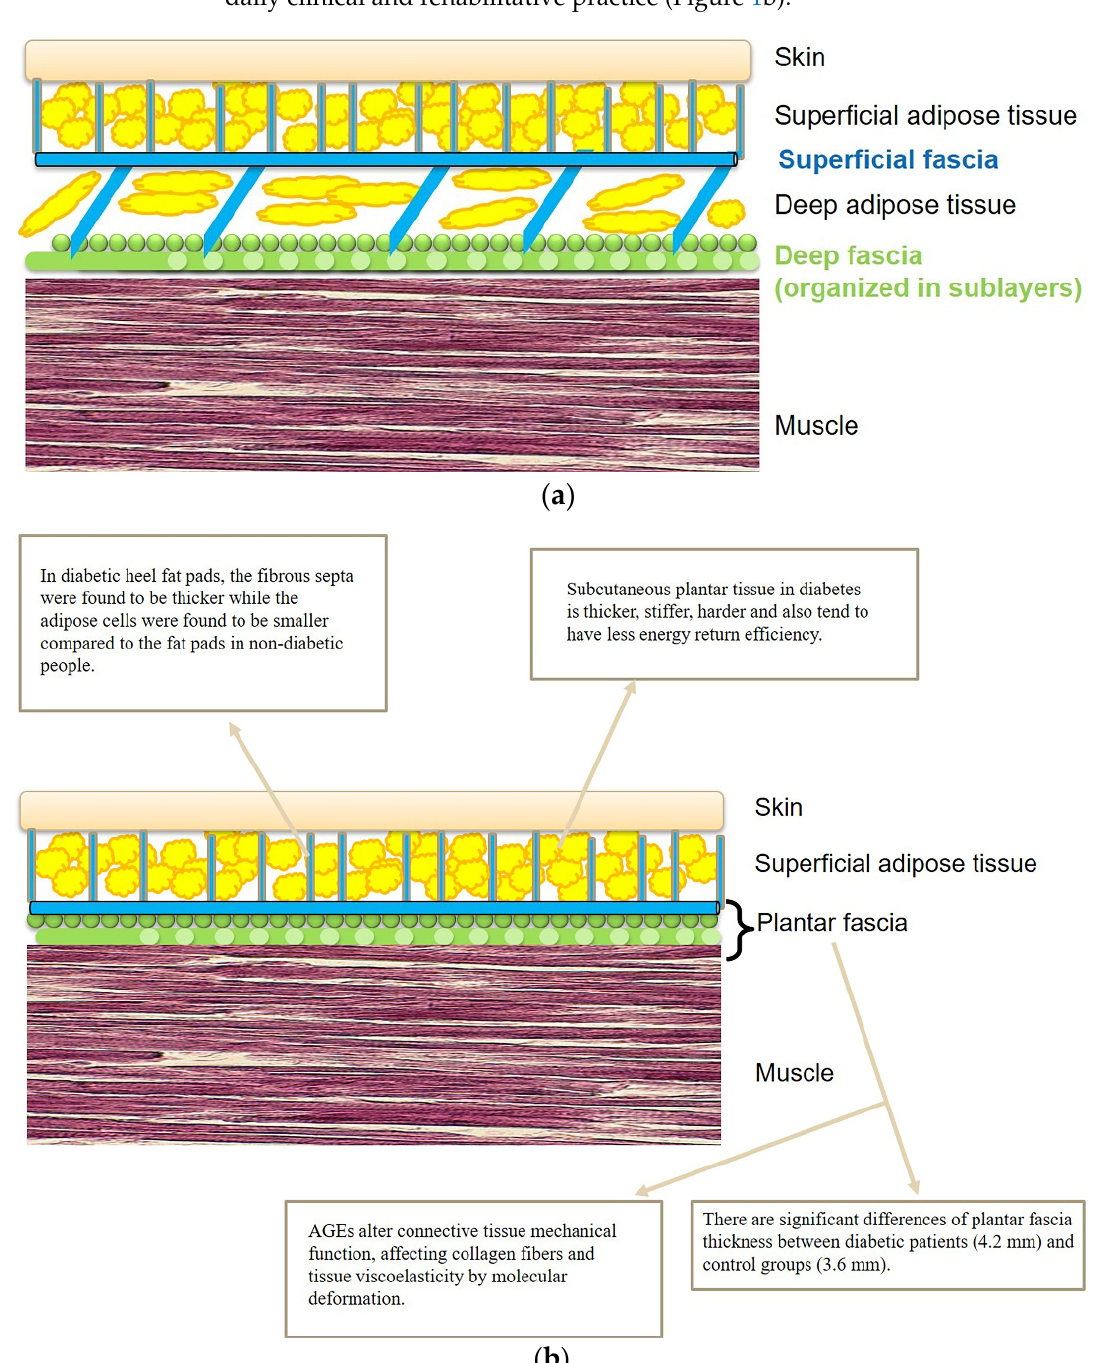
Figure 1. Schematic representation of the various fasciae from skin to muscle: ( a ) dorsum of the foot, ( b ) plantar region of the foot.